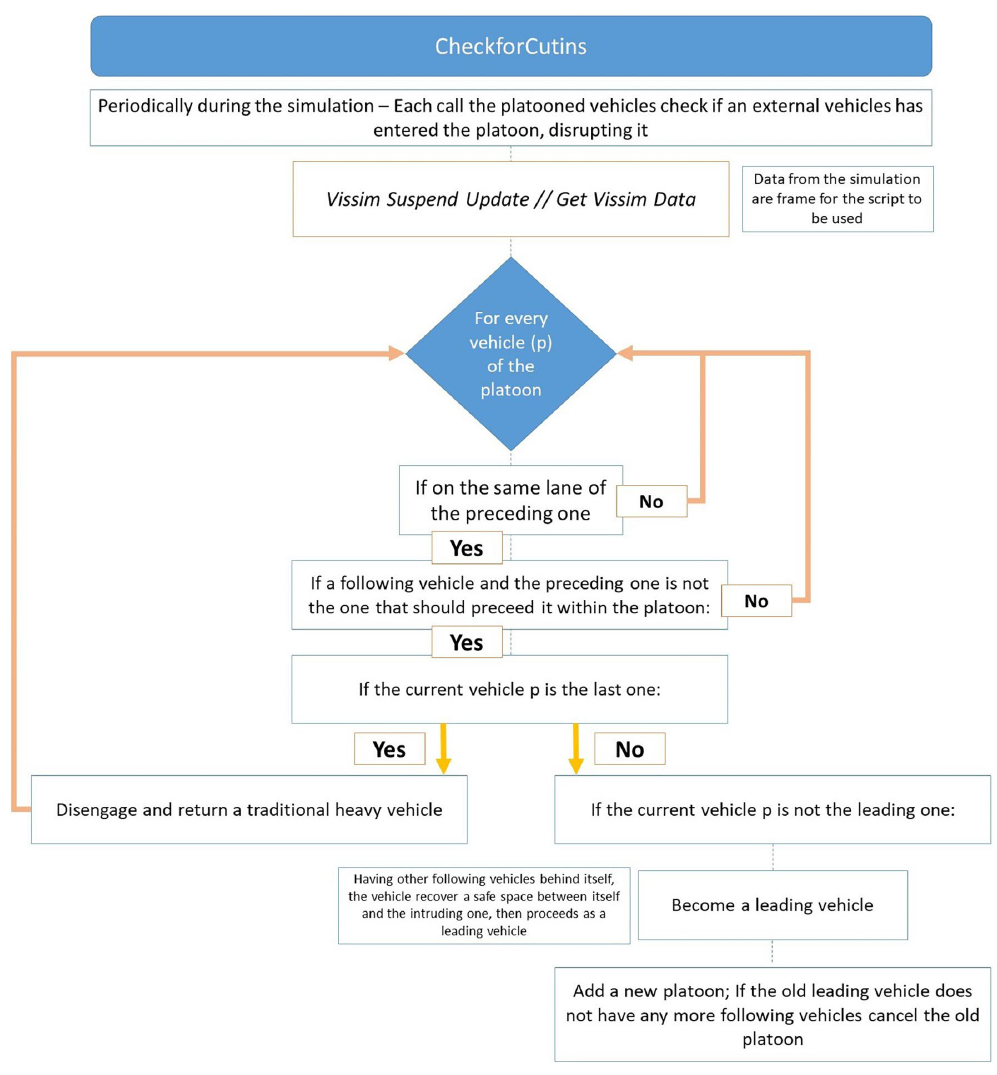
Figure 5. CheckforCutins